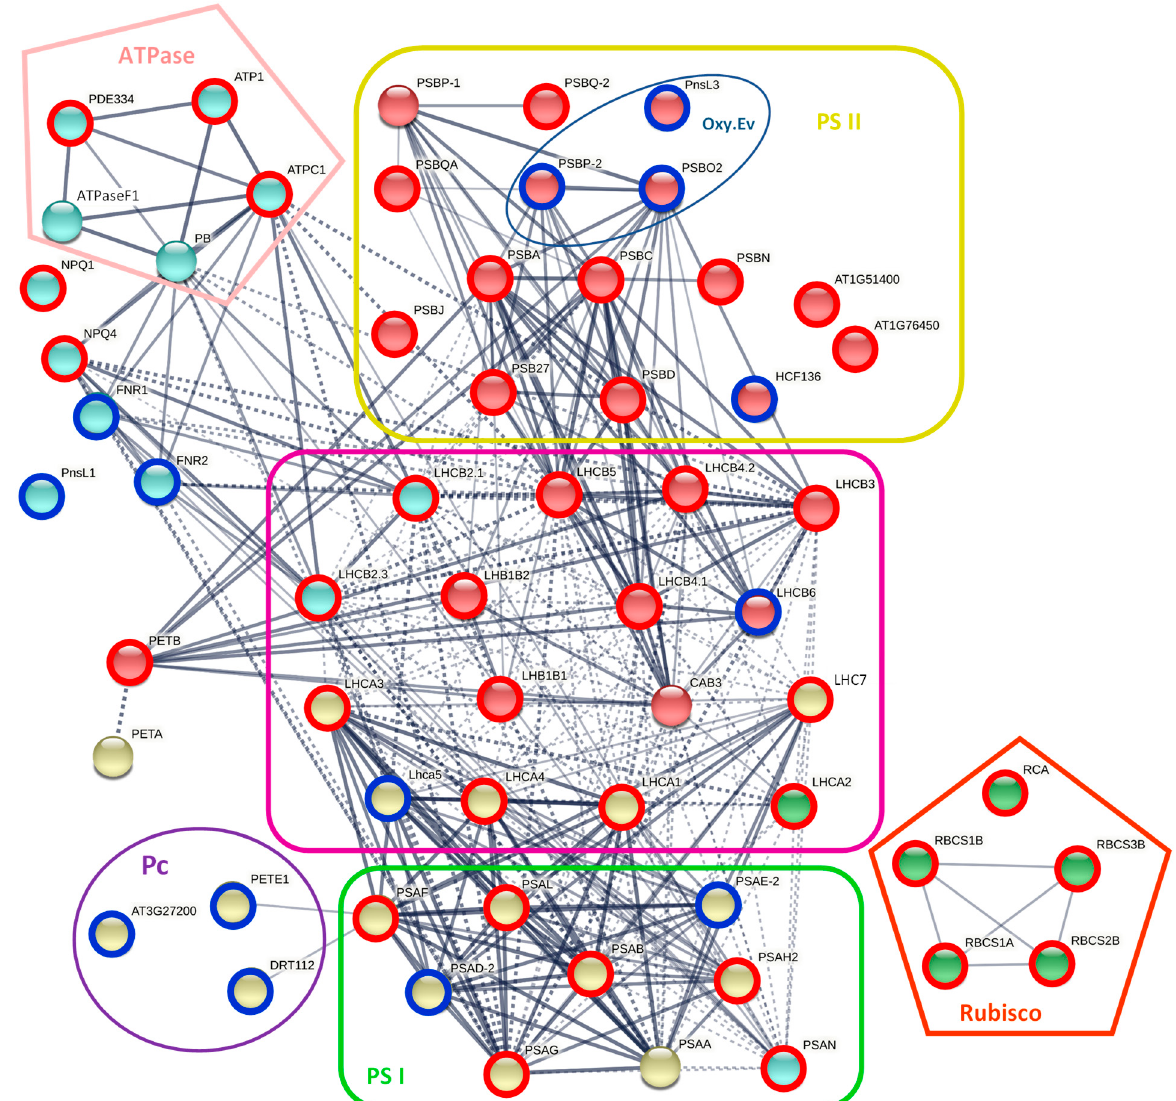
Figure 7. Graphical representation of protein-protein interaction network analysis of photosynthesis-related DAPs in R. serbica HL and DL performed by STRING software. K-means clustering into five clusters emphasizes distinct photosynthetic complexes. Connections between clusters are shown by dotted lines. A physical subnetwork is shown (connected proteins are part of the same physical complex). Line thickness indicates the strength of data support. For the minimum required interaction score, medium confidence was set at 0.400. Proteins rounded in blue were more abun- dant, while those rounded in red were less abundant upon desiccation. Abbreviations refer to sym- bols and annotation identifiers of the respective A. thaliana orthologous.